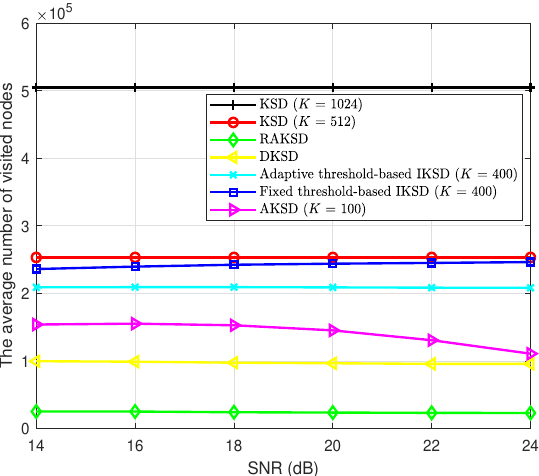
Figure 4. The complexity comparison of KSD algorithms for a 64 × 64 MIMO system with